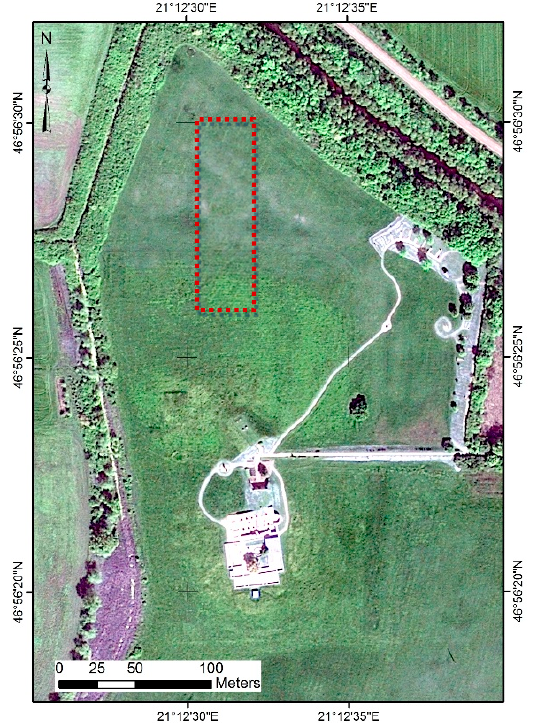
Figure 1. Case study area—Vészt ő -Mágor Tell: The red polygon indicates the area covered from the geophysical survey (GPR measurements) and ground spectroradiometric measurements (Latitude: 46°56 ′ 24.36 ′′ ; Longitude: 21°12 ′ 32.67 ′′ , WGS84) (Figure from [5]).